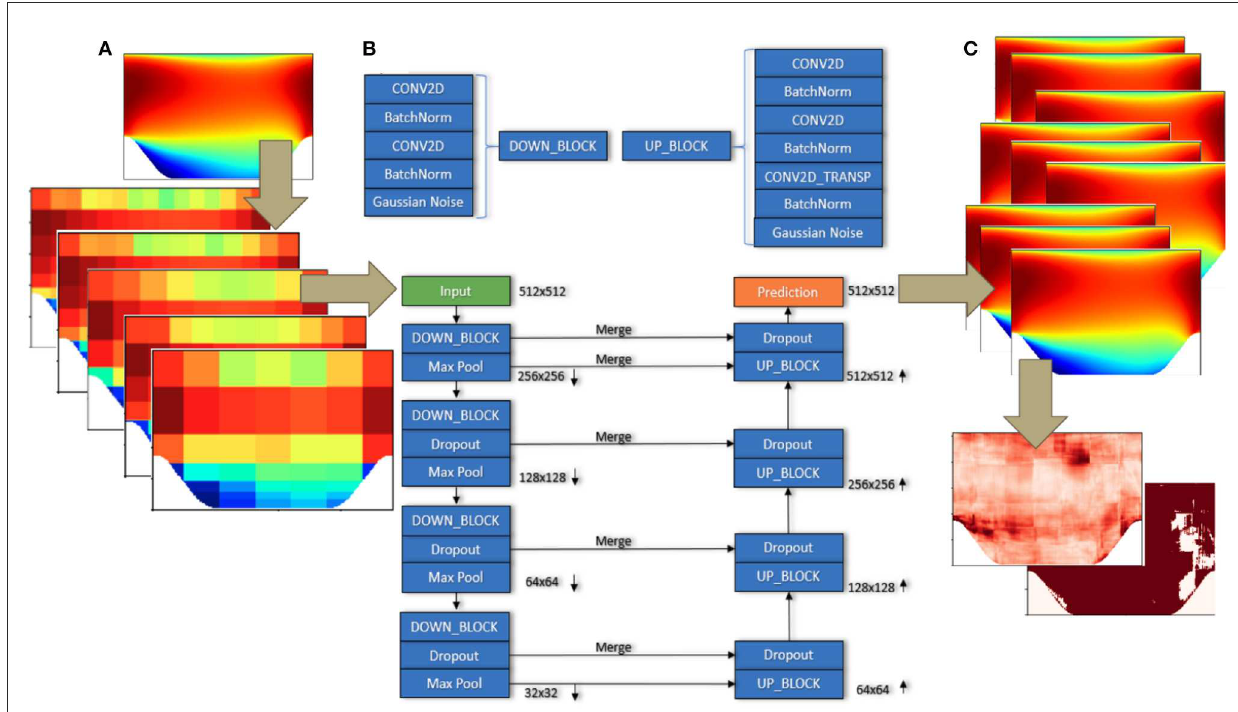
FIGURE1 A schematic of the proposed super-resolution framework. (A) Shows the creation of an augmented and downsampled input feature space from the input field using Voronoi tessellation, (B) shows the chosen U-net architecture containing additional dropout and batch normalization layers, and (C) shows the ensemble of super-resolved field outputs along with the estimated uncertainties and error bounds.